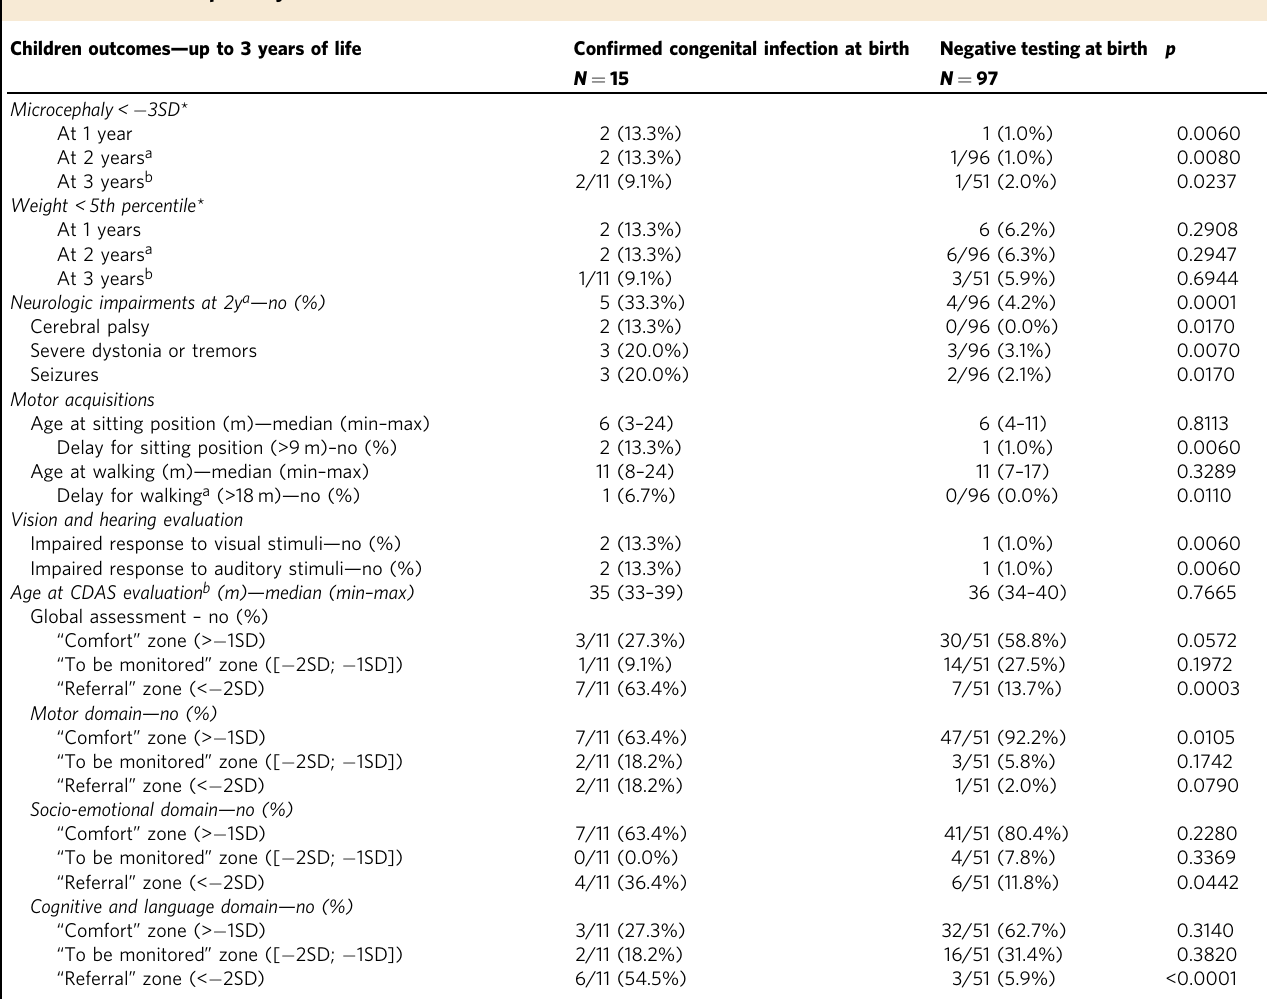
Fig. 3 Head circumference and weight in children tested positive and negative for congenital Zika infection at birth. Head circumferences (in centimeters) and weights (in kilograms) are presented for each time point of this study (birth, 1 month, 2 months, 1 year, 2 years, 3 years). Boxes represent median and interquartile range (IQR), whiskers represent range excluding outliers >1.5× IQR from upper or lower quartile, and circles represent outliers. Z- (blue): Children tested negative at birth for congenital Zika infection; Z + (red): children tested positive at birth for congenital Zika infection. n = 129 neonates at birth (18 Z + / 111 Z − ), n = 128 infants at 1 and 2 months (17 Z + / 111 Z − ), n = 112 infants at 12 months (15 Z + / 97 Z − ), n = 111 children at 24 months (15 Z + / 96 Z − ), n = 62 children at 36 months (11 Z + /51 Z − ). Table 4 Outcomes up to 3 years of